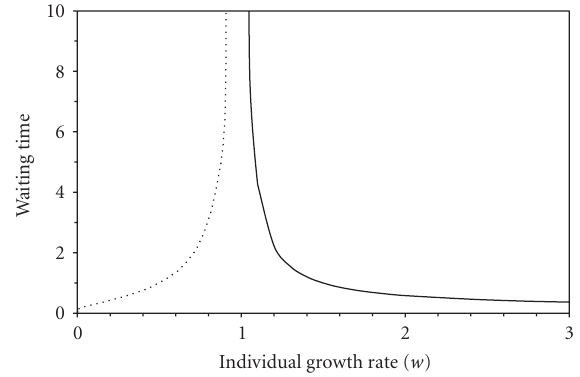
Figure 4: Waiting time to death (dotted line) or reproduction (solid line) as a function of individual growth rate. (From (11) and